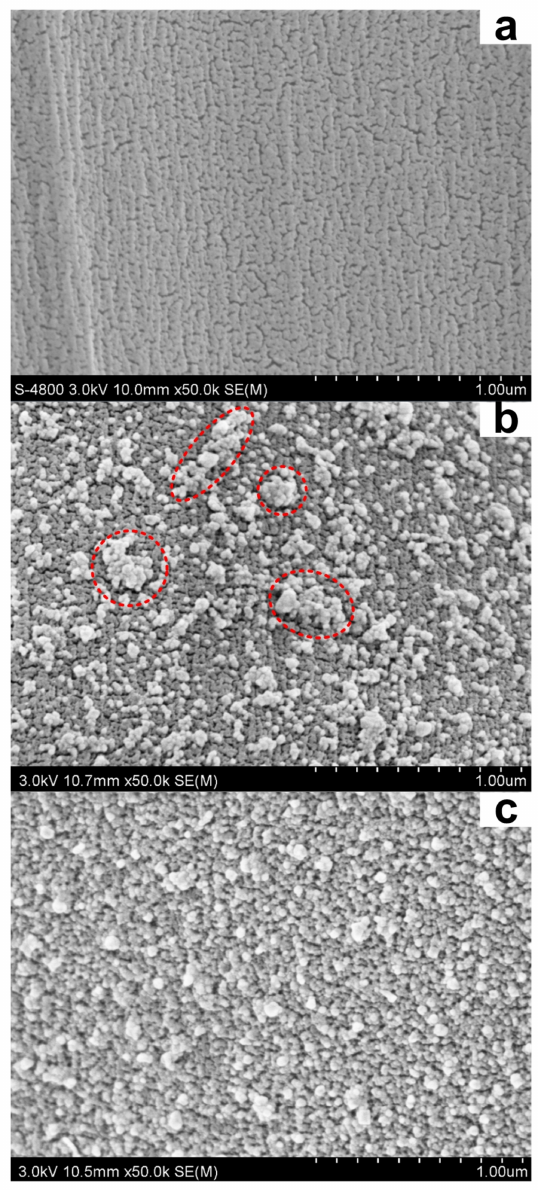
Figure 9. SEM images of the untreated silk ( a ) and the silk treated with AgNPs synthesized using quercetin ( b ) and rutin ( c